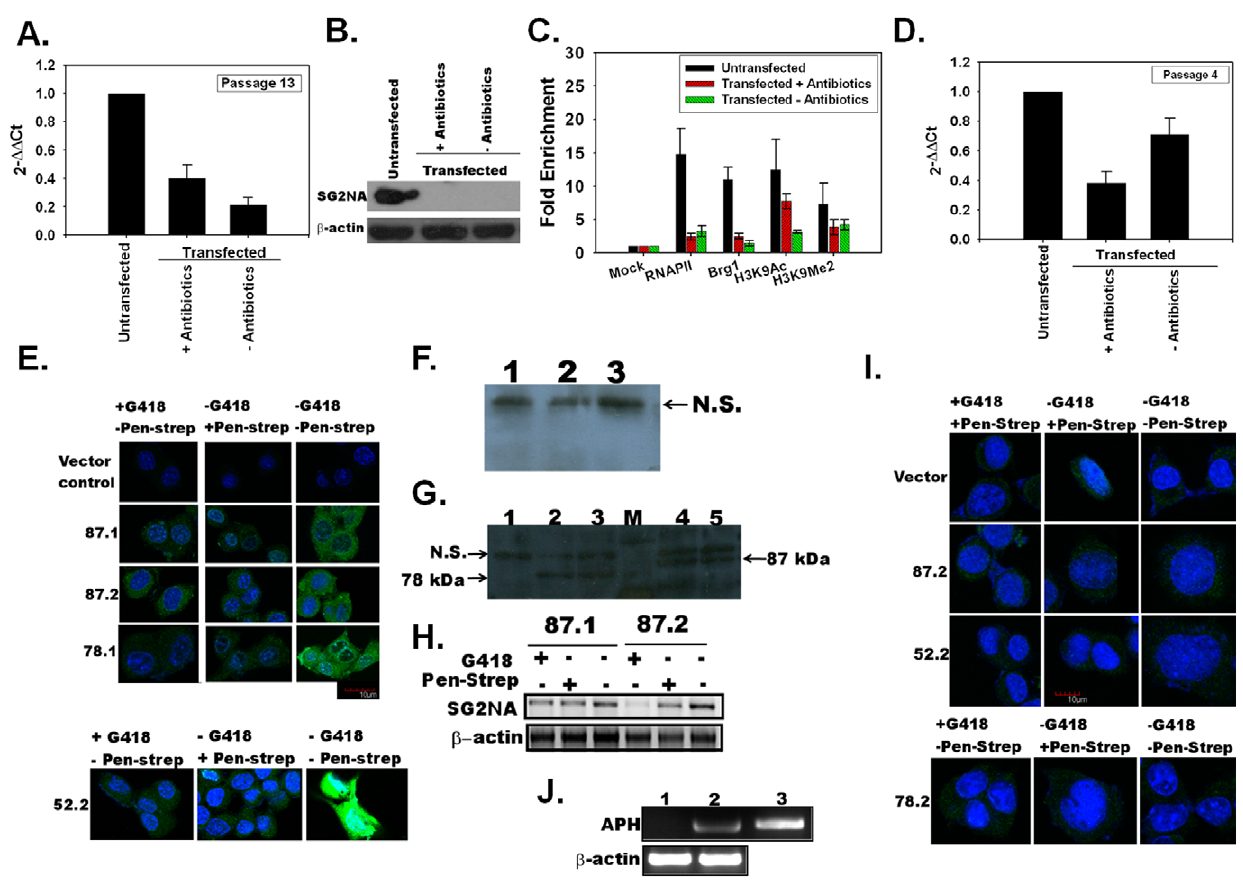
Figure 6. Expression of endogenous SG2NA is influenced by ADAADi production. The transcript as well as protein expression was monitored in the untransfected cells as well as in cells stably transfected with pcDNA 3.1 myc/his ( 2 ) vector at passage 13. (A). Endogenous SG2NA transcript was analyzed by quantitative RT-PCR in untransfected and transfected Neuro 2Acells. (B). Endogenous SG2NA protein analyzed by western blot using antibody against SG2NA. (C). sg2na promoter occupancy by RNAPII, Brg1, H3K9Ac, and H3K9Me2 was analysed in untransfected and transfected Neuro 2A cells using ChIP. Fold enrichment was calculated with respect to the mock ChIP done using IgG antibodies. (D). SG2NA transcript level in transfected cells at passage 4. (E). Expression of exogenous SG2NA expressed using pcDNA 3.1 myc/his ( 2 ) vector is also influenced by ADAADi production. Overexpression of three variants of SG2NA in Neuro2A cells were monitored using anti-myc antibody. Transfected cells (passage 4) were grown as indicated for 12 hours before analysis. Two clones of 87 kDa (87.1 and 87.2), one clone each of 78 kDa (78.1) and of 52 kDa (52.2) were analyzed for protein expression. The cells transfected with vector alone were used as control. Protein expression was observed only when cells were grown in the absence of both antibiotics. (F). Western blot analysis of expression of 87- and 78-kDa proteins in clones 87.1 and 78.1 in stably transfected cells grown in the presence of antibiotics using anti-myc antibody. Lane 1: vector alone transfected cells; Lane 2: 78.1 clone; Lane 3: 87.1 clone. N.S., indicating non-specific band, was used as loading control. (G). The expression of 78- and 87- kDa protein in 78.1, 78.2, 87.1 and 87.2 clones was monitored in stably transfected cells grown in the absence of antibiotics. Lane 1: vector transfected cells; Lane 2: 78.1 clone; Lane 3: 78.2 clone; M: marker; Lane 4: 87.1 clone; Lane 5: 87.2 clone. N.S., indicating non-specific band, was used as loading control. (H). Semi- quantitative RT-PCR analysis done using insert-specific forward primer and vector-specific reverse primer confirms that 87 kDa transcript expression is observed only when the cells are grown the absence of antibiotics. (I). The expression of 87 kDa, 78 kDa, and 52 kDa was not observed in stably transfected cells even after removal of antibiotics when the cells were freeze-thawed at passage 9. (J). Semi-quantitative RT-PCR analysis of APH transcript. Lane1: Untransfected Neuro2A cells; Lane 2: Stably transfected Neuro2A cells; Lane 3: control reaction using purified pcDNA 3.1 myc/his ( 2 ) vector.